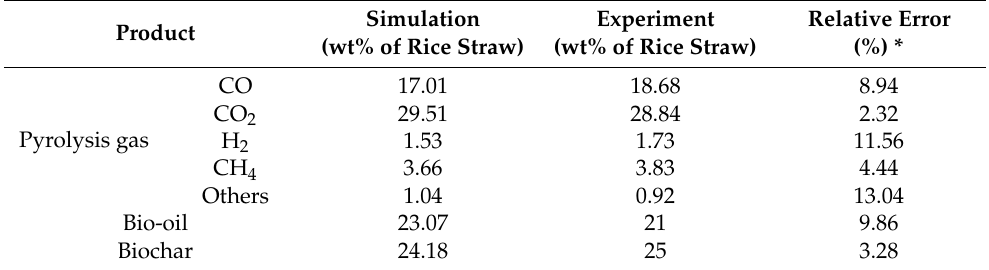
Table 6. The simulation and experiment results of the rice straw pyrolysis [24]. Simulation Experiment Relative Product (wt% of Rice Straw) (wt% of Rice Straw)